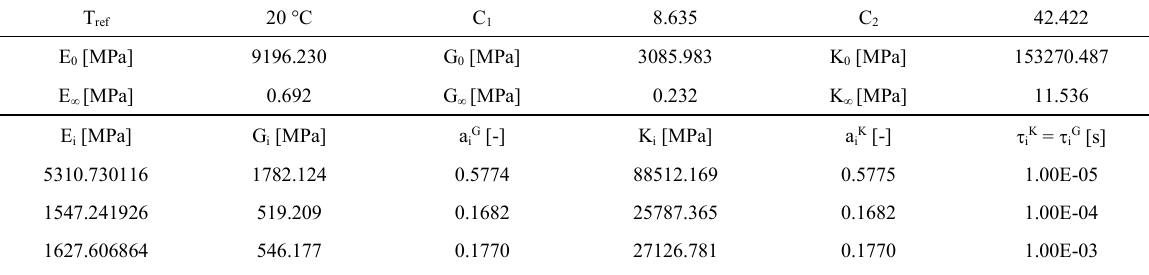
Table 2: Maxwell Prony parameters of Trosifol  BG R20 based on combined shear and torsion DMTA